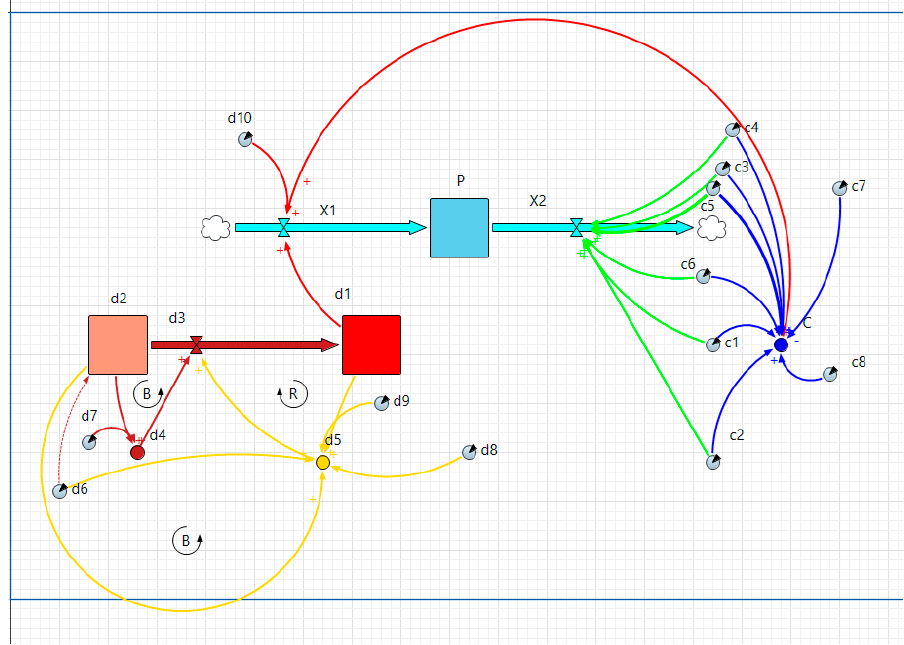
Figure 12. Model for projecting the profit of the farm. Source: designed by authors. Figure 12 shows the connections between all the variables and with the flows. The blue color demonstrates the connections between the variables affecting the pricing, the green one shows the connections affecting the costs and the red one shows the connections influencing the